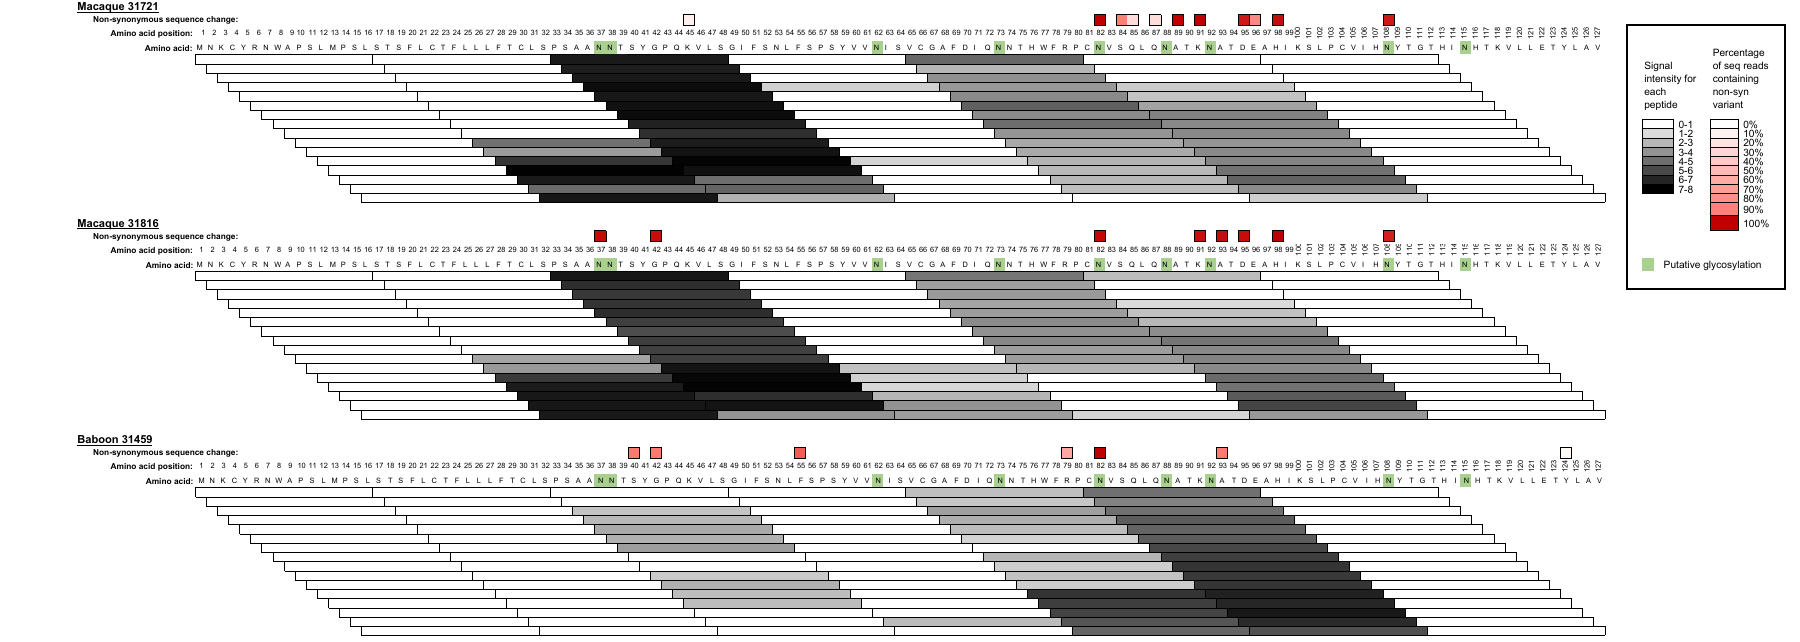
Figure 6. Correlation of SWBV mutations with antibody responses. Antibody binding intensity data (see Figure 5) are shown for each peptide covering the region of interest in GP5 as a heat-mapped scale of 0 (white) to >7 (black). Overlaid are the non-synonymous sequencing changes corresponding to each amino acid of GP5 (see Table S1), with a heat-map highlighting variants contained in 20% (pink) to 100% (dark red) of deep sequencing reads. Amino acids in green highlight residues with predicted N-linked glycosylation. Data for each animal correspond to analysis of the day 56 post-inoculation time-point with the exception of sequencing data from baboon 31459, for which day 12